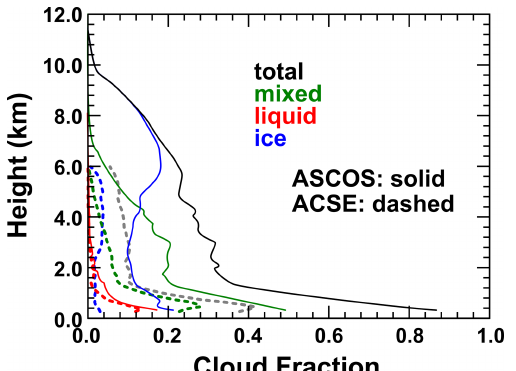
Figure 14. Fraction of non-precipitating (solid) and precipitating (dashed) mixed-phase clouds observed during ACSE in summer (black) and autumn (red) in comparison to the entire ACSE data set (grey) as well as to previous observations of mid-level clouds at mid-latitudes from ground (Bühl et al., 2013) and space (Zhang et al.,